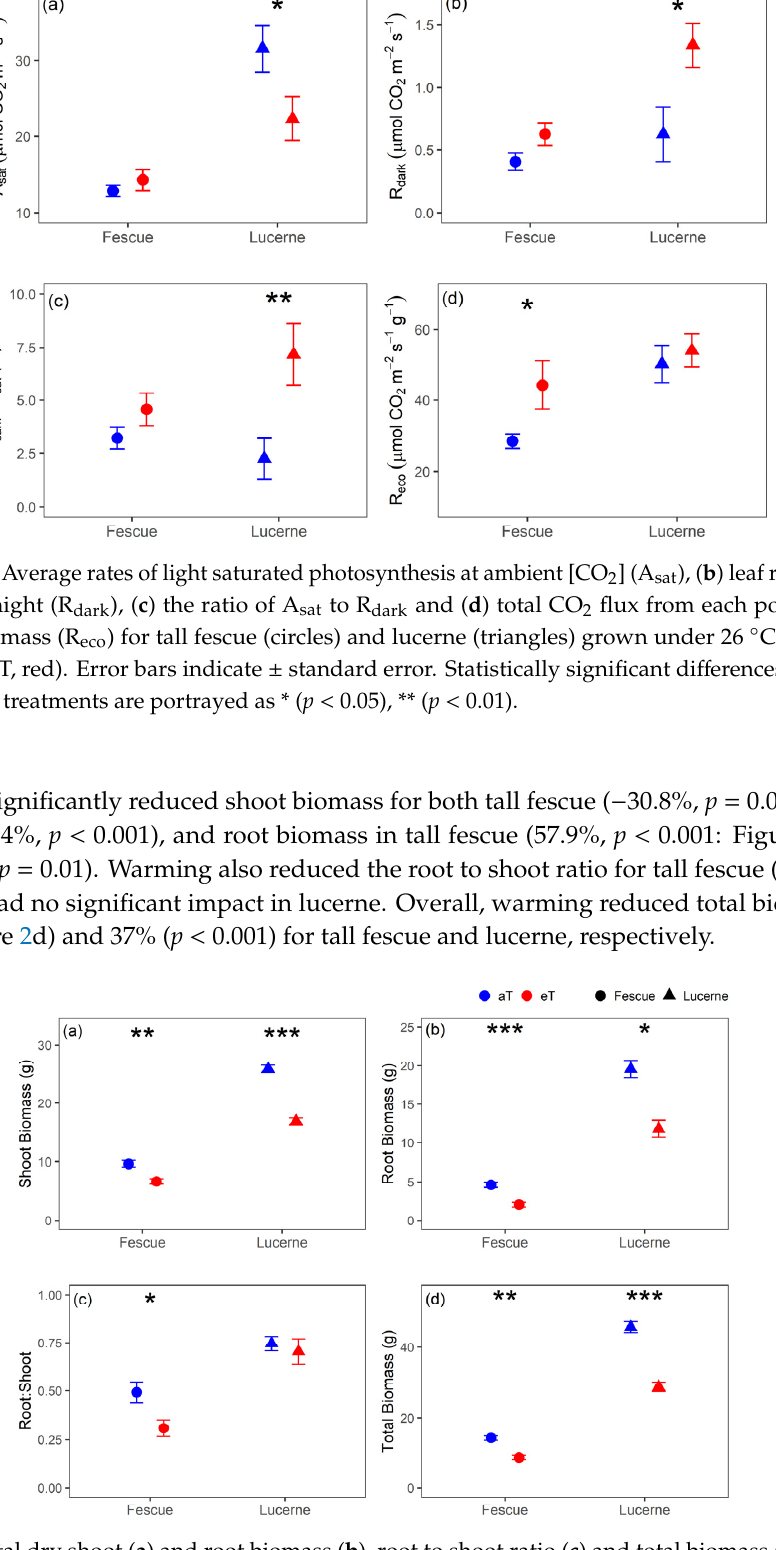
Figure 2. Total dry shoot ( a ) and root biomass ( b ), root to shoot ratio ( c ) and total biomass ( d ) for tall fescue (circles) and lucerne (triangles) grown under 26 ◦ C (aT, blue) and 30 ◦ C (eT, red). Error bars indicate ± standard error ( n = 8). Statistically significant di ff erences between temperature treatments are portrayed as * ( p < 0.05), ** ( p < 0.01), *** ( p <